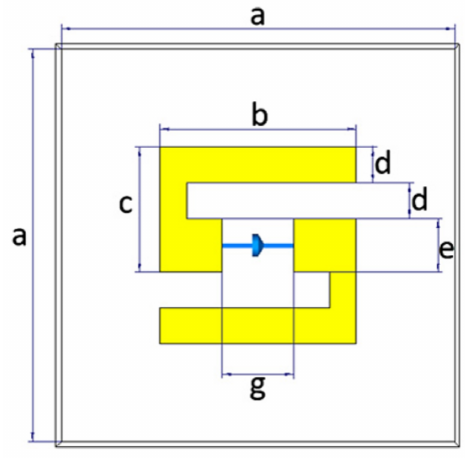
Figure 4. Unit cell of the metamaterial-based harvester (Figure 1 of Ref.